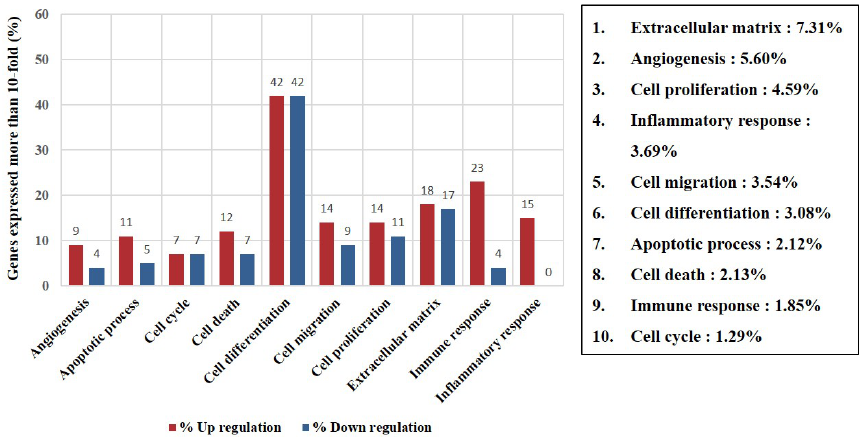
Figure 6. Expression of filtered gene categories. Distribution and ratio of genes in 10 selected categories with 10-fold increased expression ( p < 0.05). Table 1. Genes upregulated more than 10-fold in 3D- compared to 2D-cultured sPDLSCs. Fold Gene Name Change